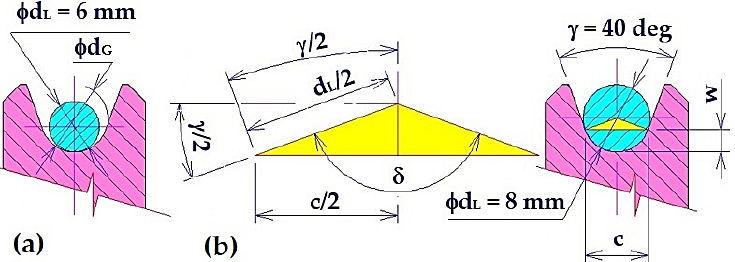
Figure 8. Diameter d G [m], dihedral angle γ [deg] and angle δ [deg] of the semi-circular groove. For the rope of φ 8 mm, see Figure 8b, the experimental values of friction coefficient done for semi-circular groove f (i) [-] reached higher values that the value given in the standard [13]. The φ 8 rope is showing 40.28% contact of its circumference with the groove surface φ d G = 8 mm. Angle δ [deg] and the length of the rope circumference contact with the groove o [m] can be expressed by the relationship (4).